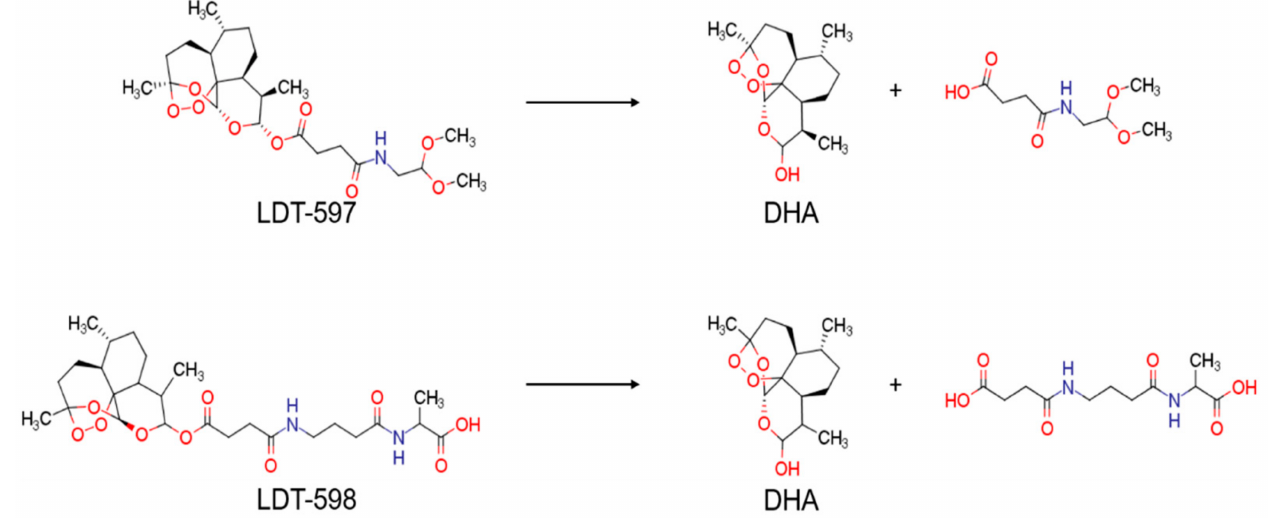
Figure 4. Predicted metabolism of compounds LDT-597 and -598 via plasma carboxylesterases predicted using the software